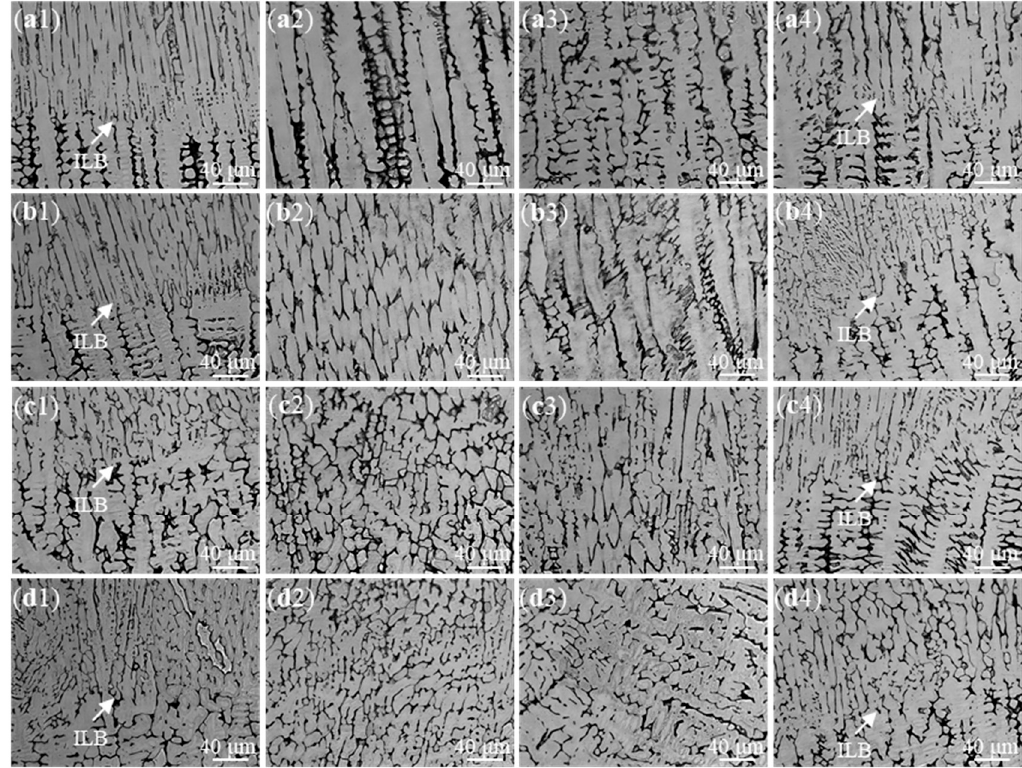
Figure 3. The microstructure between two adjacent ILB in different treatment (Y - Z plane): ( a1 – a4 ) sample C2, ( b1 – b4 ) sample C3, ( c1 – c4 ) sample U2, ( d1 – d4 ) sample U3.